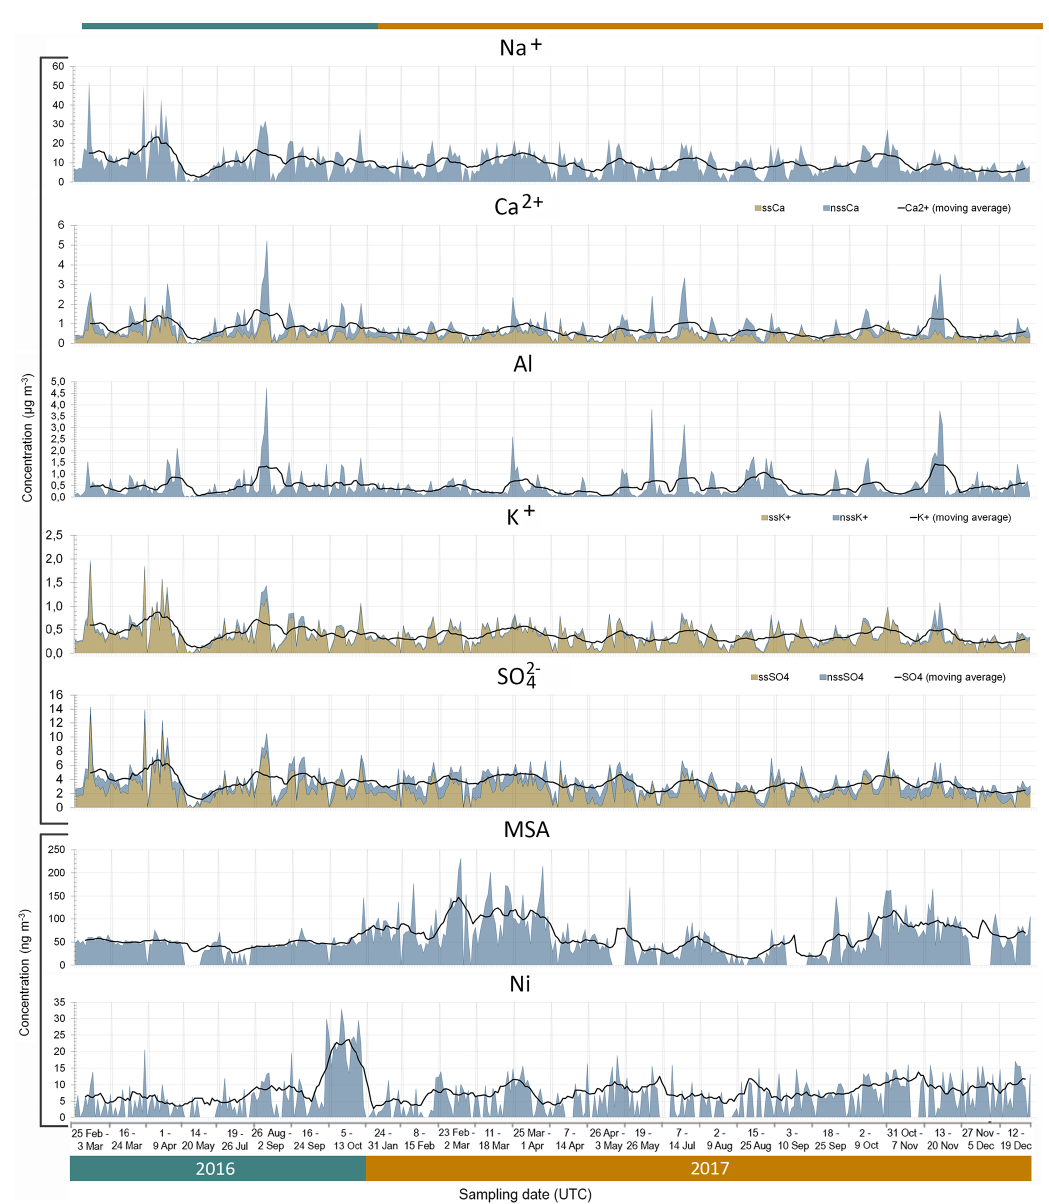
Figure 5. Time series (date, time in UTC) of measured concentrations for Na + , Ca 2 + , Al, K + , SO 2 − black line indicates the calculated 10-point moving average. The sea salt (ss) components for Ca 2 + , K + and SO 2 − orange shaded areas, and the non-sea salt (nss) fraction is represented by the blue shaded areas. The time series is non-consecutive and is divided into the 26 sampling weeks by the light grey vertical